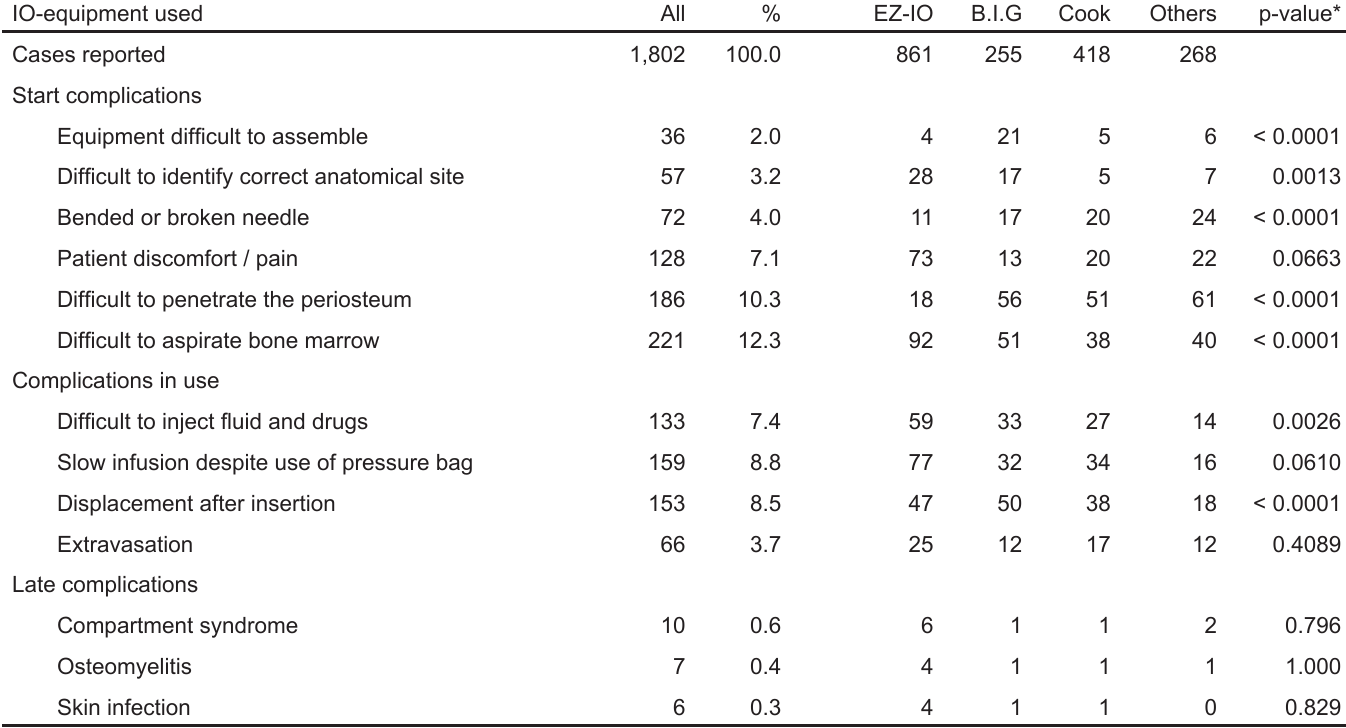
Table. Complication rate with intraosseous access (IO) reported by Scandinavian users - listed by device. IO-equipment